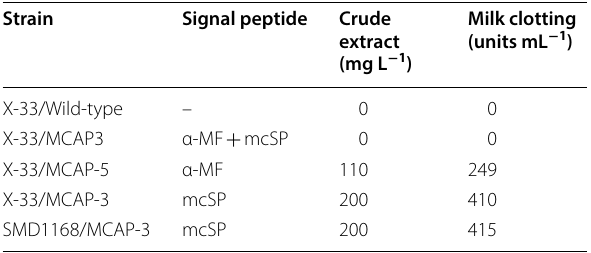
Date are given as average, n